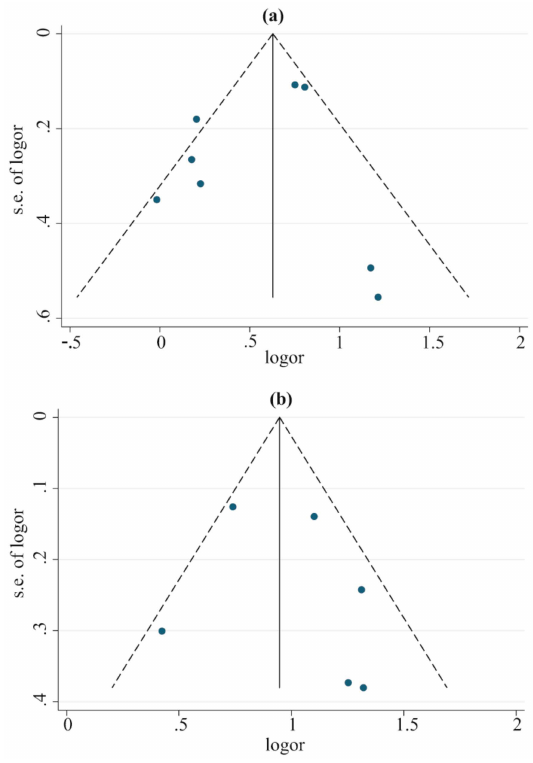
Figure 2. Funnel plots to analyze publication bias for the associations between the HLA-DQB1*02 and HLA-DRB1*03 polymorphisms and the risk of LADA: ( a ) DQB1*02 ; ( b ) DRB1*03 . Note: s.e.: standard